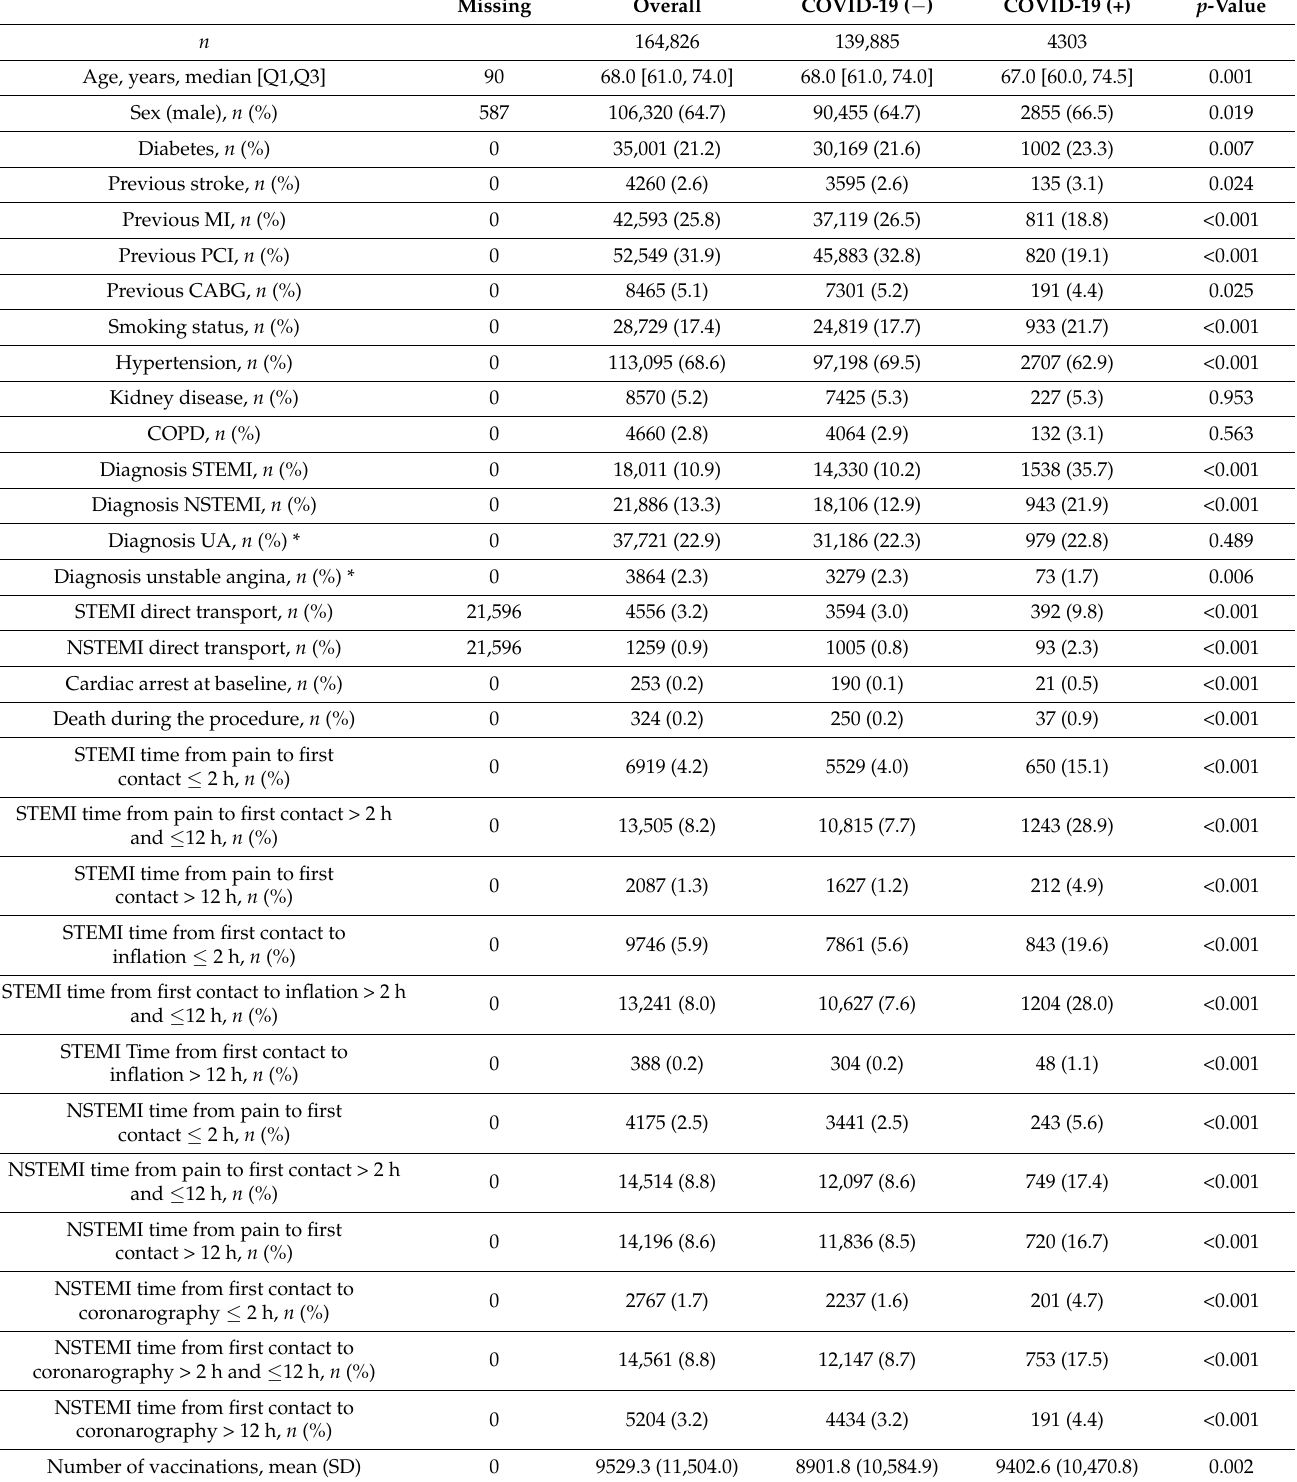
Table 2. Characteristics of patients analyzed in